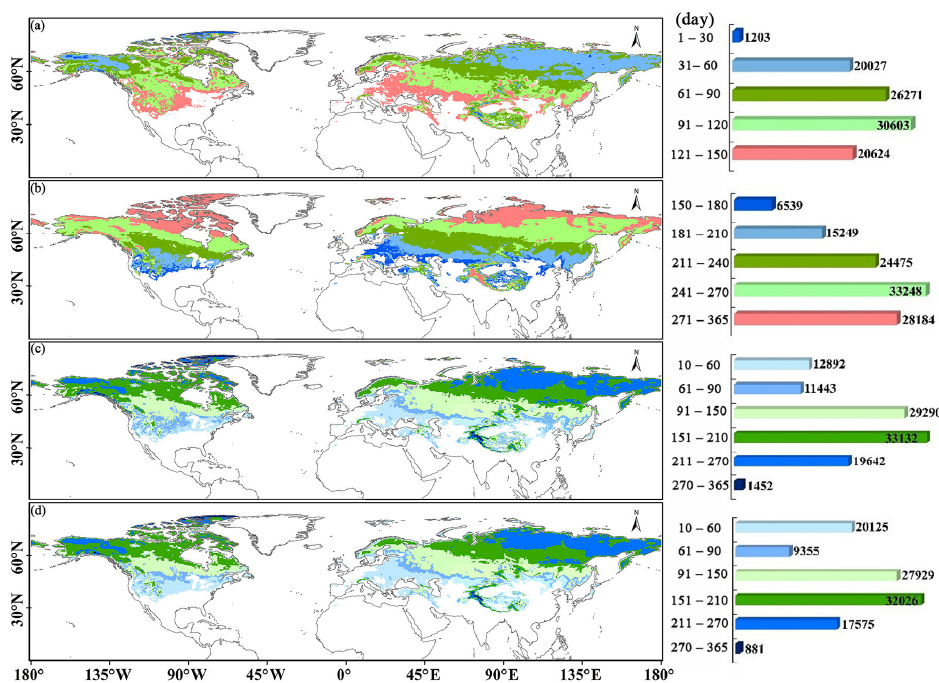
Figure 6. Spatial distributions of the annual ( a ) SCOD, ( b ) SCED, ( c ) SSL, and ( d ) SCD in the NH. The bar charts on the right correspond to the ( a ) SCOD, ( b ) SCED, ( c ) SSL, and ( d ) SCD legends.